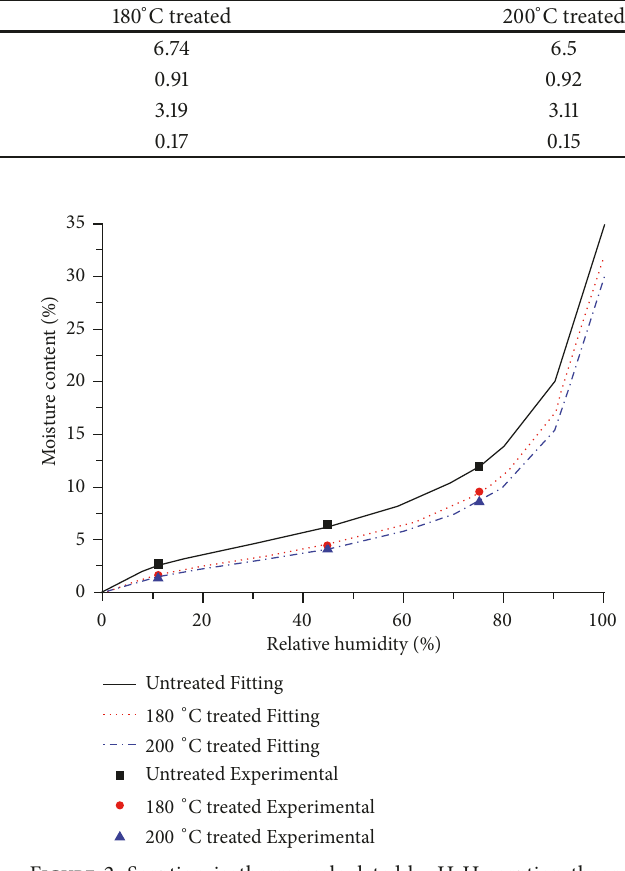
Figure 2: Sorption isotherms calculated by H-H sorption theory and a comparison with experimental